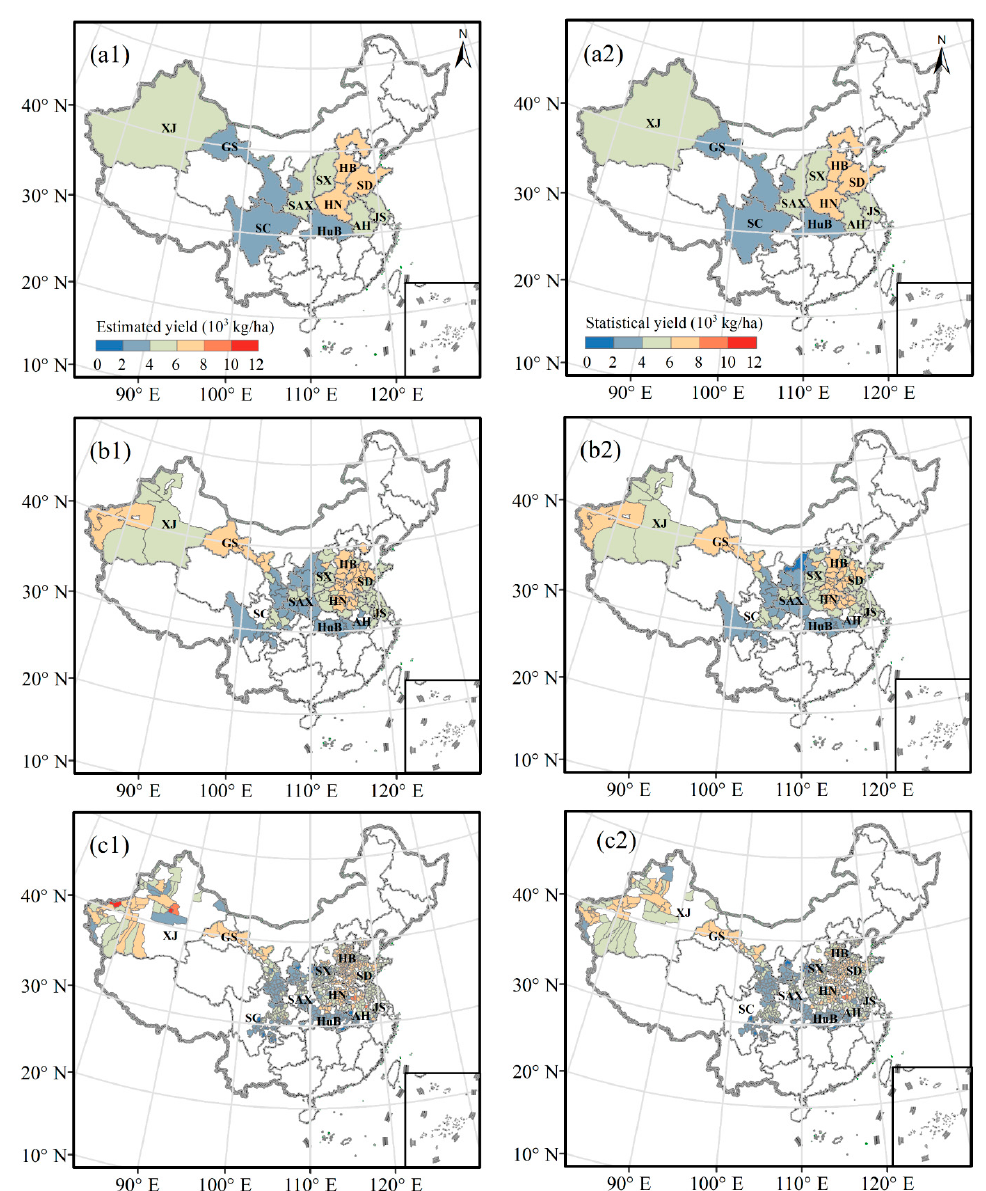
Figure 7. Spatial distribution of estimated and statistical mean winter wheat yield from 2016 to 2018 at the province, municipal and county scale, respectively. Here, ( a1 ), ( b1 ) and ( c1 ) show the spatial distribution of estimated mean winter wheat yield at the province, municipal and county scales, respectively. ( a2 ), ( b2 ) and ( c2 ) show the spatial distribution of statistical mean winter wheat yield at the province, municipal and county scales, respectively.